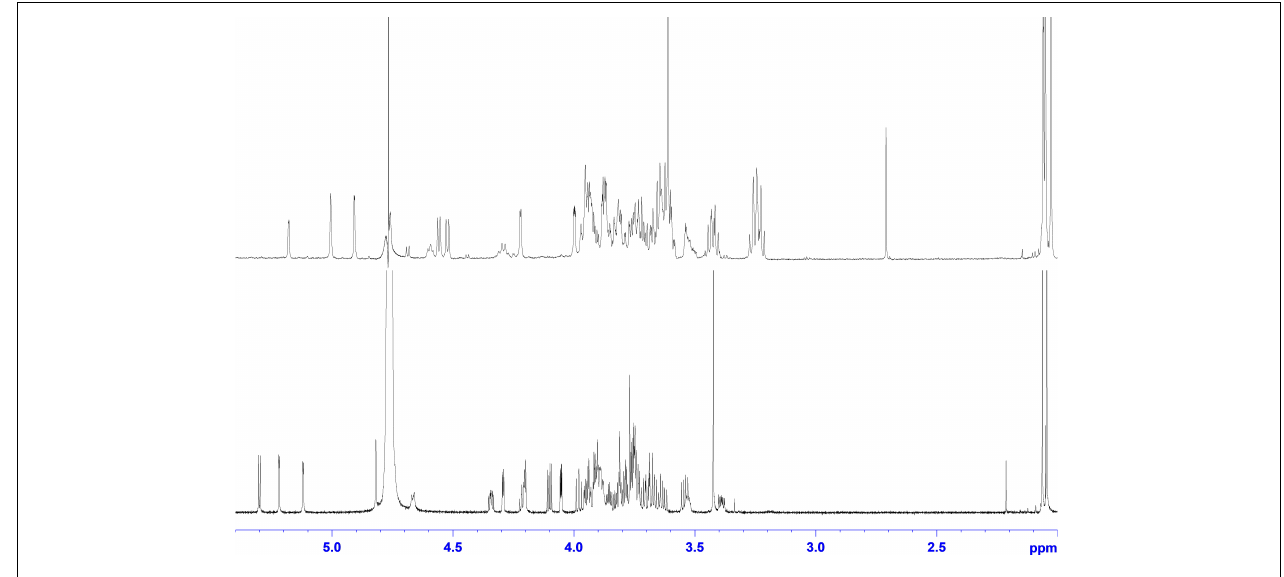
FIGURE 3 | 1 H NMR spectra of glycan preparations: bottom trace, “Raa”; top trace, “Now.”